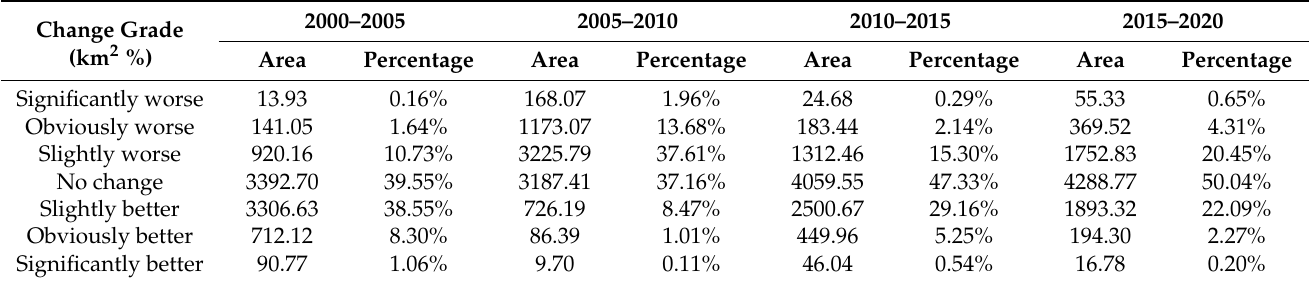
Table 6. Change in the ecological index grade from 2000 to